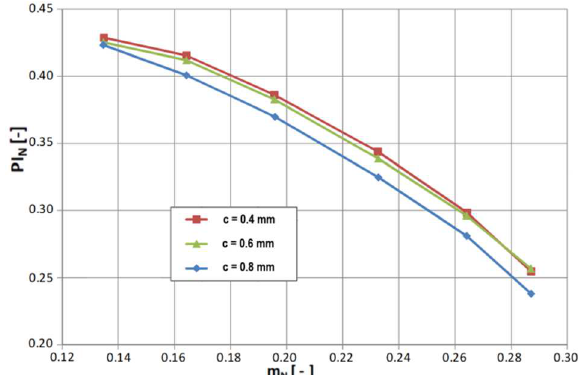
Fig. 14. Measured pressure characteristics of the stage with various clearance width of the impeller shroud disc seal at Ma 2u =